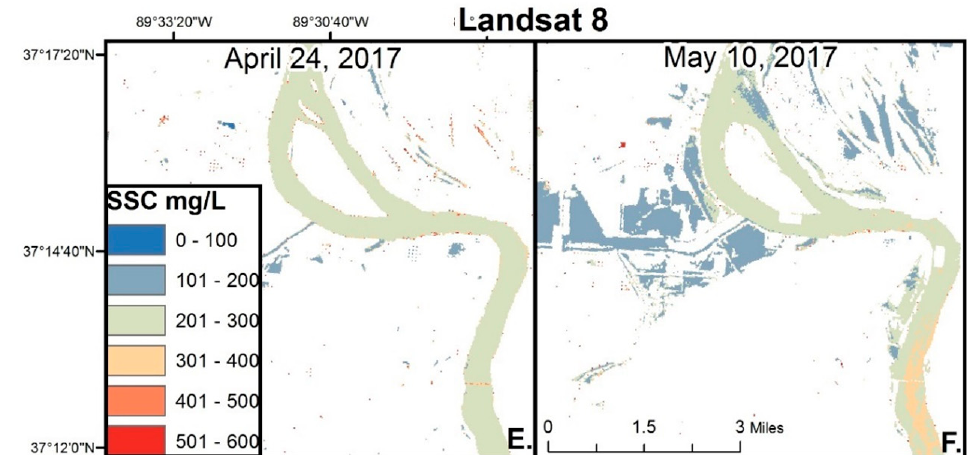
Figure 4. Maps of predicted SSC based on the ELM model for the three test cases. Panel A displays Landsat 4–5 SSC predictions for 21 April 2010, and Panel B shows the SSC predictions for 10 May 2011 for the area surrounding Cairo, IL. Panels C and D represent the SSC conditions pre- and post-rain events in 2001 based on Landsat 7 data North of St. Louis, MO. Panels E and F display the SSC conditions near Cape Girardeau, MO both pre-and post the 2017 flood event. Blue represents lower SSC while red represents higher levels of SSC.